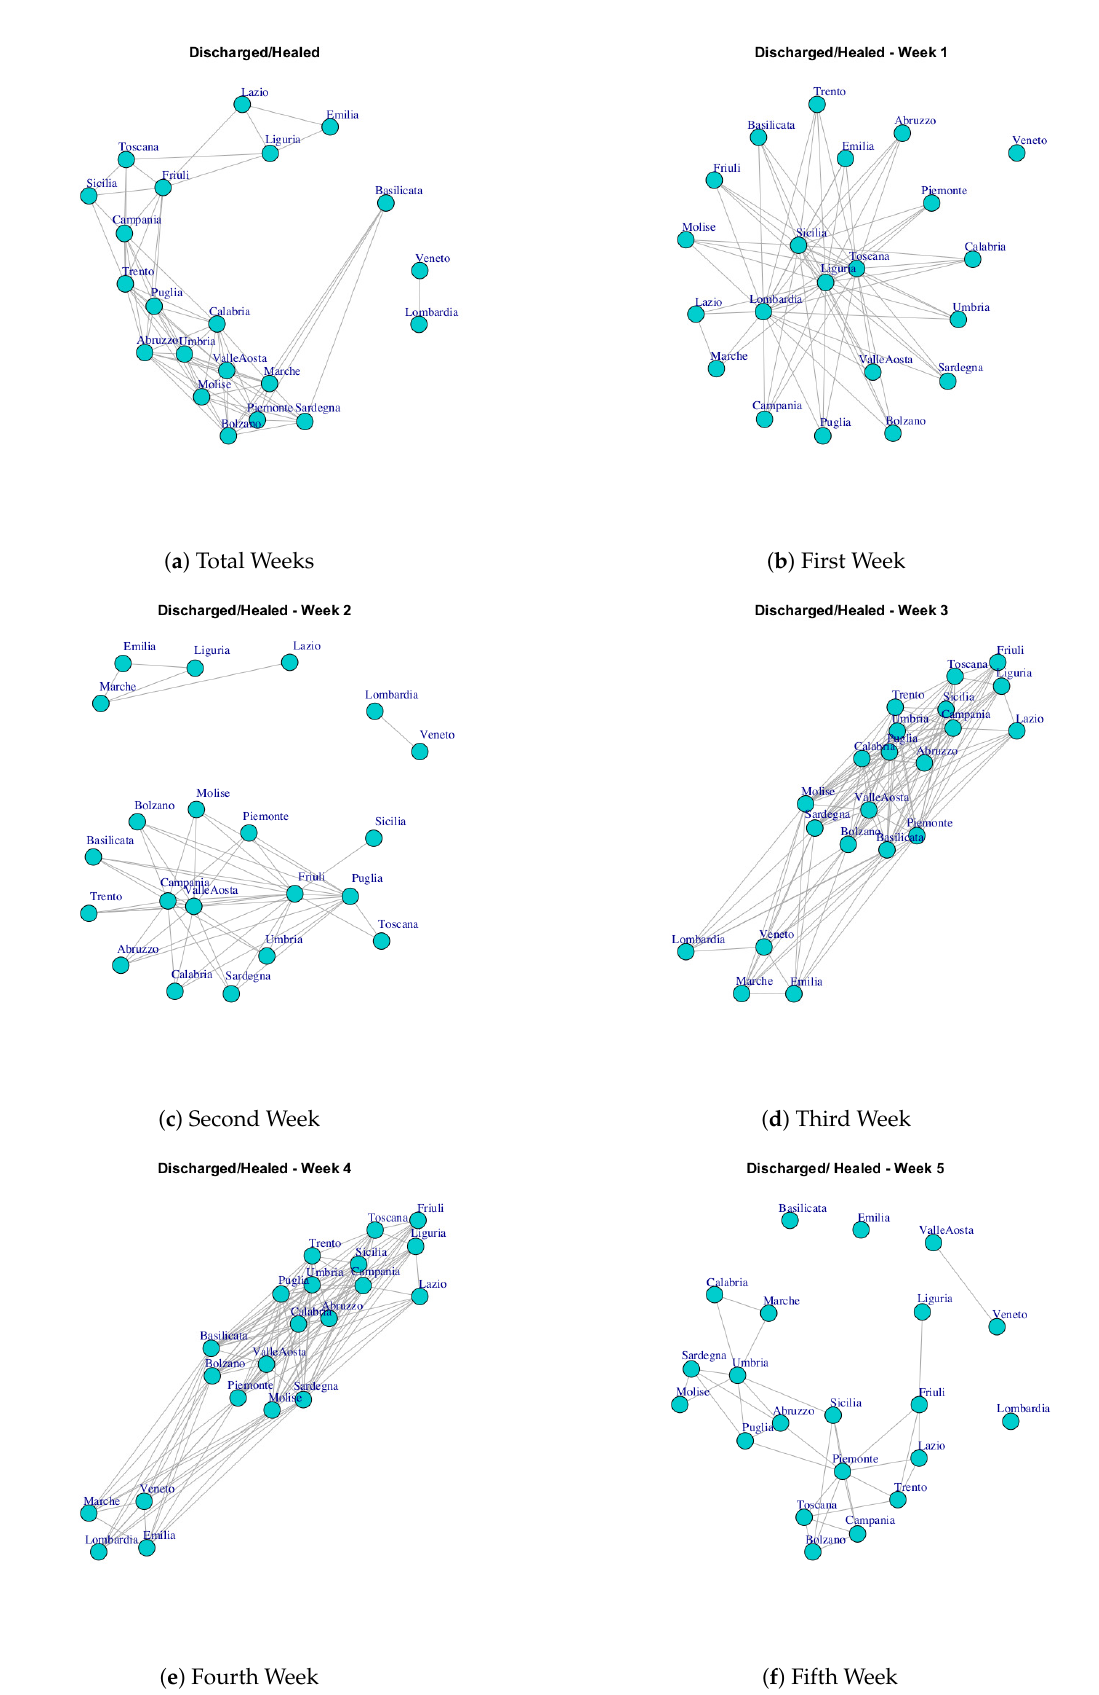
Figure 9. Evolution of Discharged/Healed